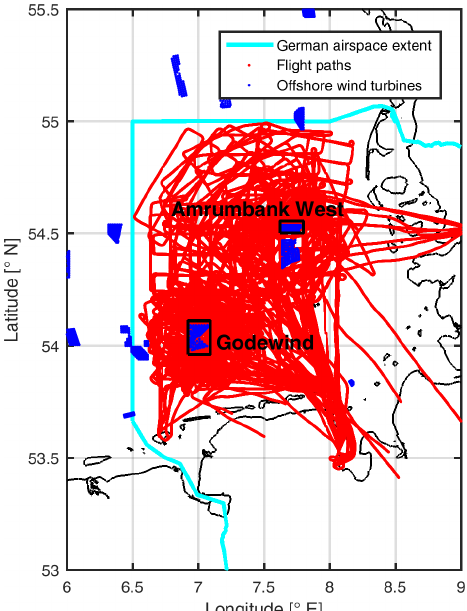
Figure 3. Tracks of all measurement flights performed during the WIPAFF experiment. The flight tracks are indicated in red. Each wind turbine installed until 2017 is represented by a blue dot. The measurements were performed from the airports Wilhelmshaven, Husum and Borkum. The wind parks Godewind and Amrumbank West are indicated with a black box. Flight tracks end when the data acquisition was shut down. The extent of the German airspace is indicated by a light blue line.